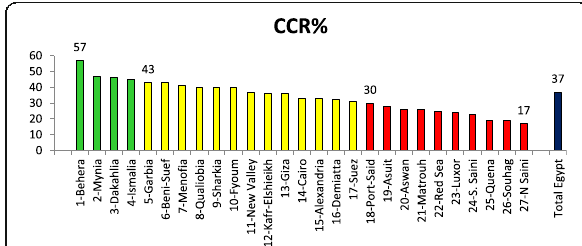
Fig. 3 Rank order of MOHP-FP clinics at governorate level according to the percent of clients reported as new FP clients (non-FP users, and discontinuers of FP use for 1 year and more)